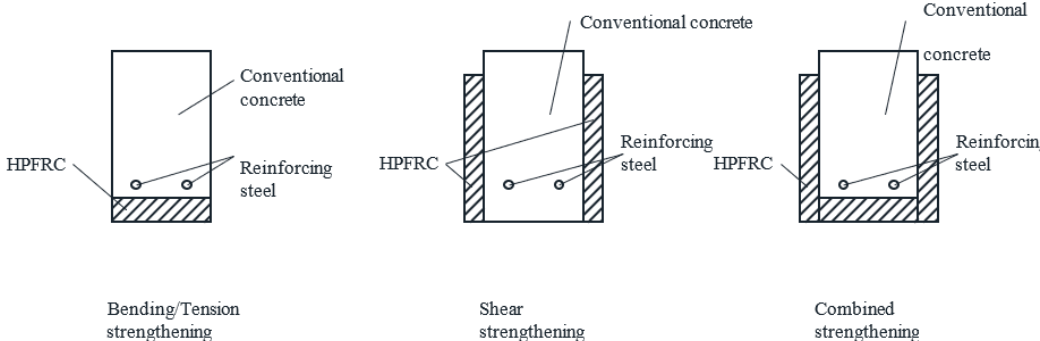
Figure 1. Possible schemes for strengthening a reinforced concrete cross-section with high-performance fiber-reinforced concrete (HPFRC) layers, abstracted from [4–9].